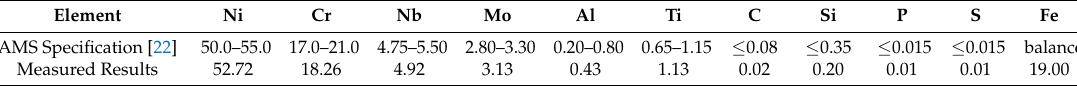
Table 1. Chemical compositions for the experimental IN718 ingot (wt